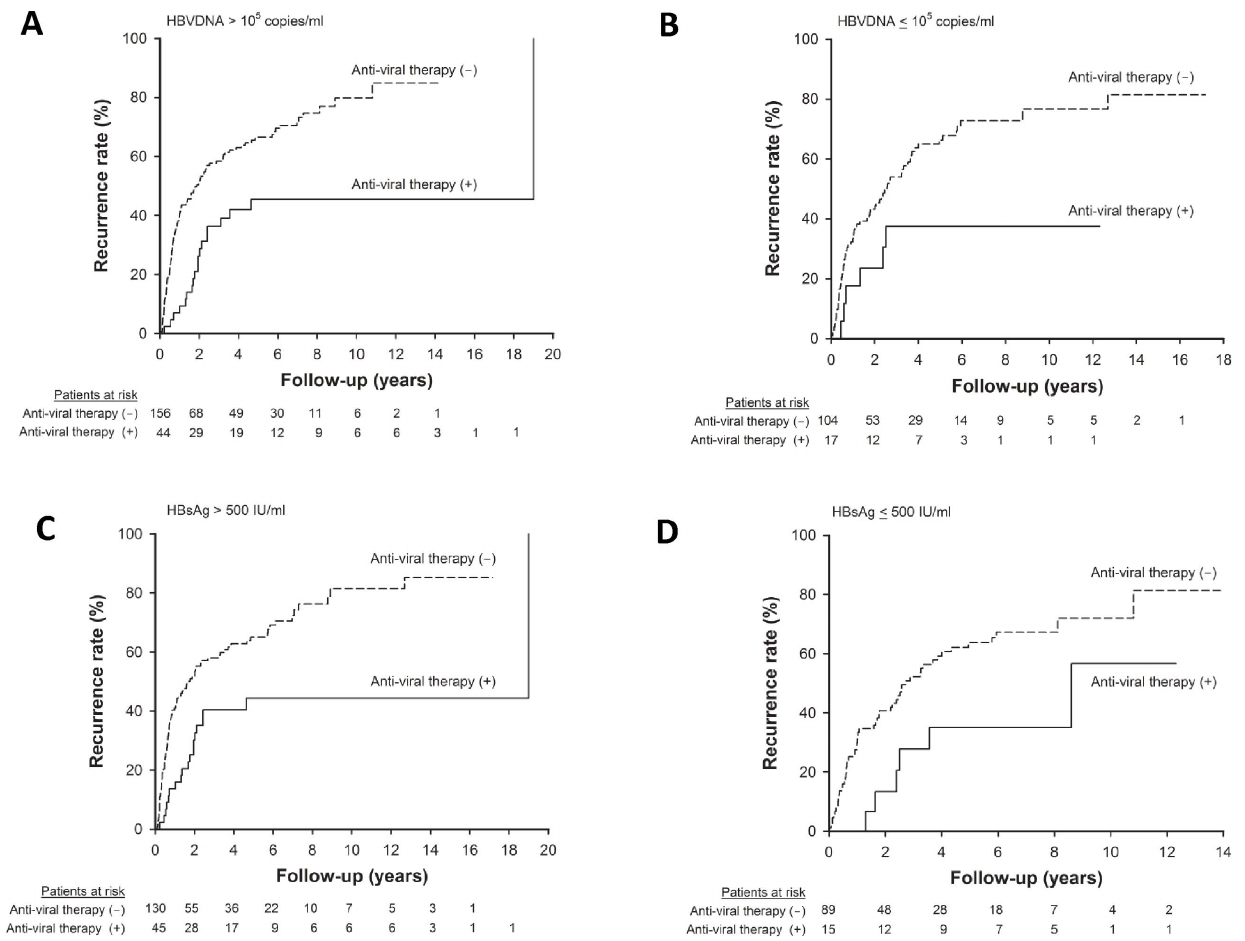
Figure 3. The impact of anti-viral therapy on post-operative recurrence stratified by viral factors. Patients who received anti-viral therapy after resection had significantly lower recurrence rate both in the setting of serum HBV DNA levels . 10 5 copies/mL ( A , p , 0.001) and # 10 5 copies/mL ( B , p =0.038). ( C ) Among patients with serum HBsAg . 500 IU/mL, anti-viral therapy was associated with lower recurrence rate ( p =0.001). ( D ) In patients with serum HBsAg # 500 IU/mL, the recurrence rates were also lower in patients receiving antiviral therapy after resection surgery ( p =0.037).